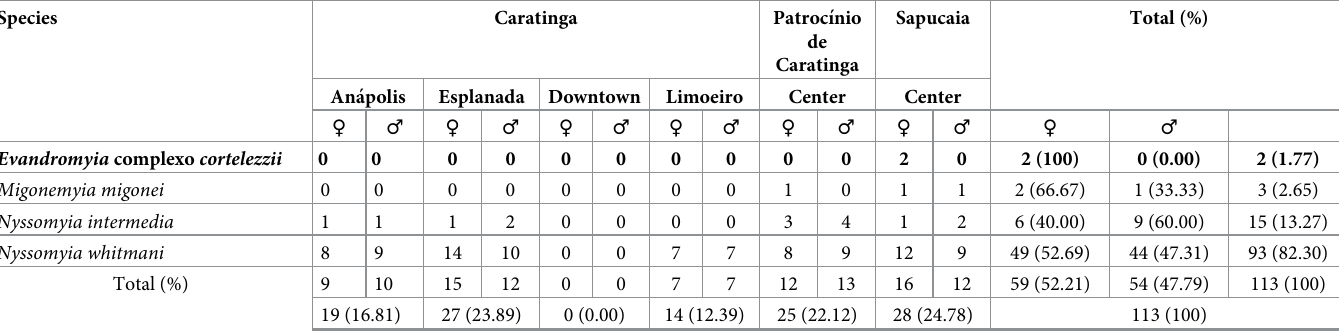
Table 6. Sandflies collected by sex and location in the urban area of Caratinga, Patrocı´nio de Caratinga and Sapucaia in July and September 2020.